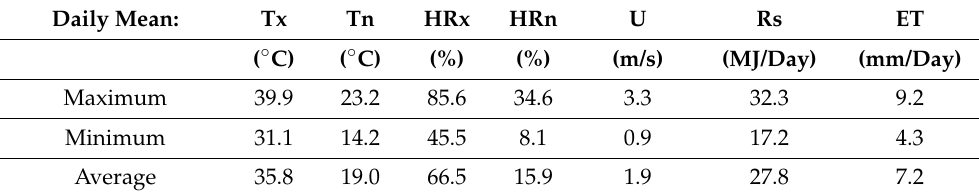
Table 1. Climatology observed during the